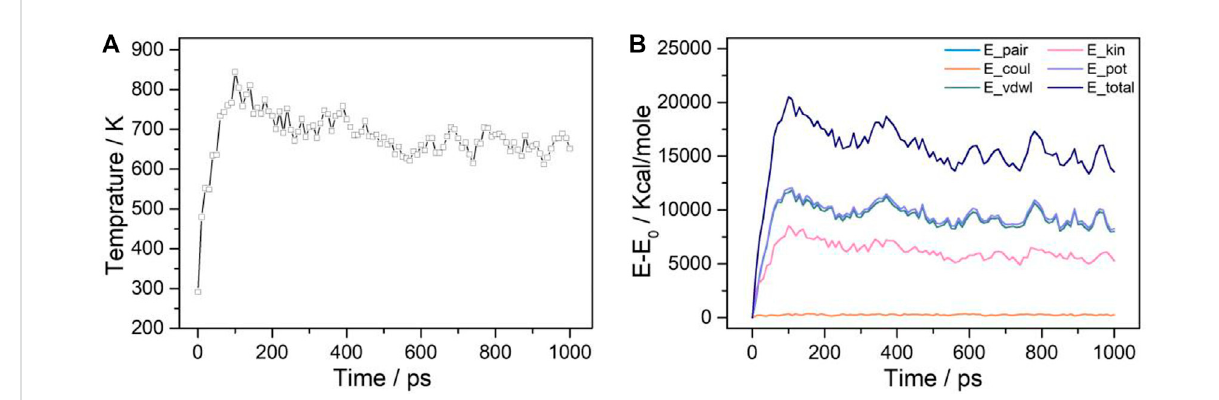
FIGURE 6 Temperature (A) and energy variation (B) of the slider during the friction process.